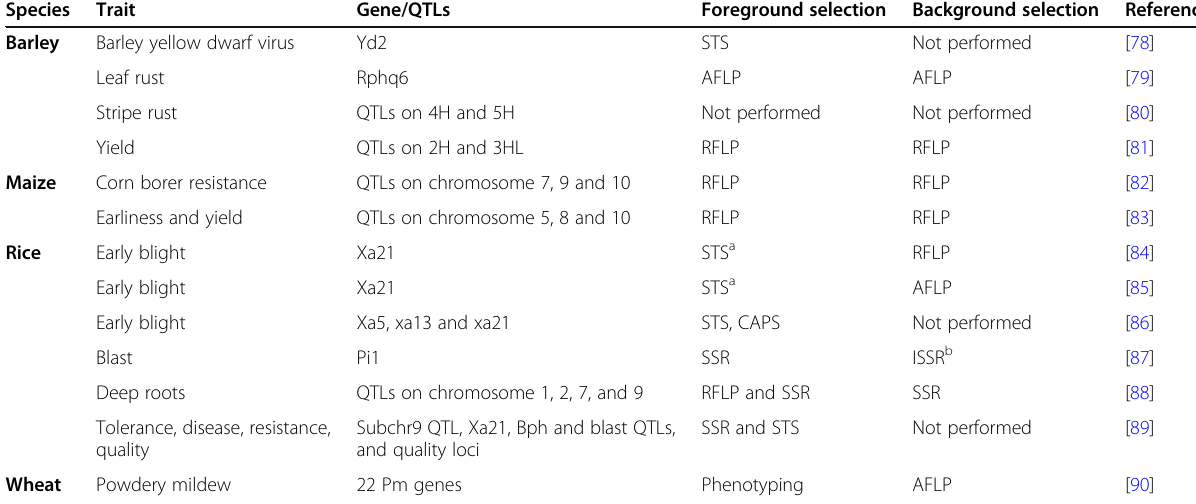
Table 3 The marker-assisted backcrossing in different crops Species Trait